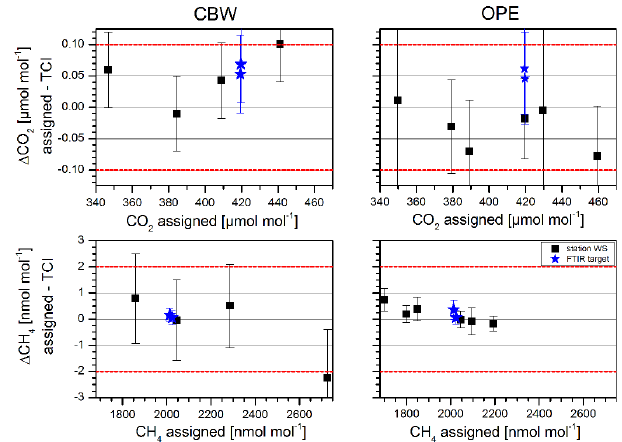
Fig. 1. Measurement of the CBW (left) and OPE (right) working standards with the TCI at the respective station (black symbols). CO 2 results are shown in the upper and CH 4 in the lower panels. The measured means are averages of two times five individual (3min) TCI measurements; the error bars give the 1 σ uncertainty of the difference accounting for the uncertainties in the assignment as well as the repeatability or the reproducibility (whichever is larger) for the TCI measurements. Blue stars denote differences of the averaged daily TCI target measurements from the CAL-assigned values and their uncertainties at the respective station. Red dashed lines show the WMO ILC target ranges for each